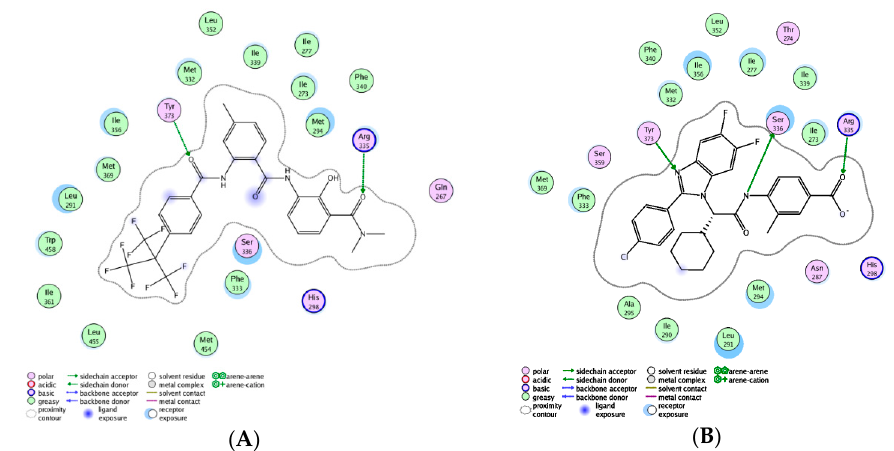
Figure 6. The 2D representation of docking of compounds N9 ( A ) and complexed ligand ( B ) into the FXR active site.